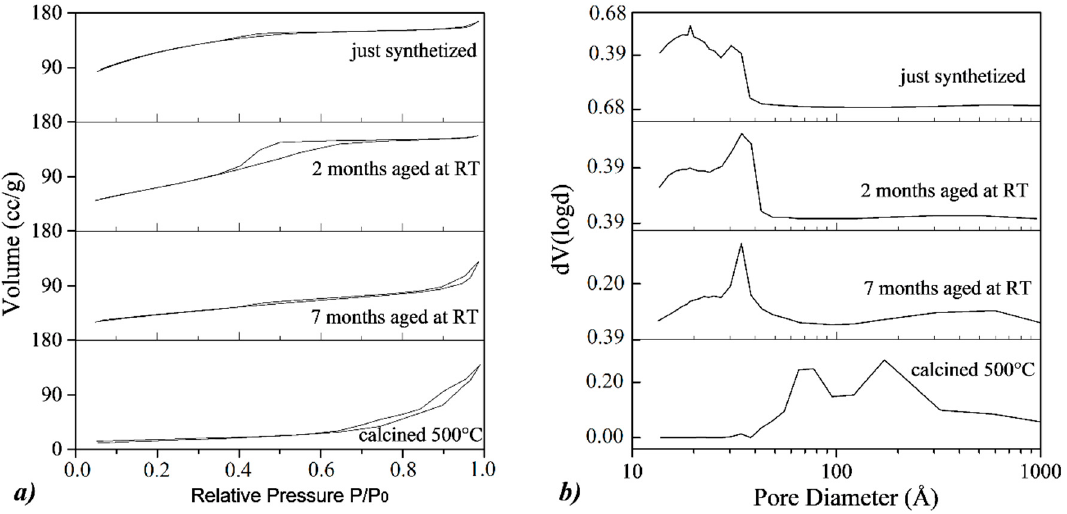
Figure 9. ( a ) N 2 adsorption / desorption isotherms and ( b ) BJH distributions for the desorption branch of the isotherms.